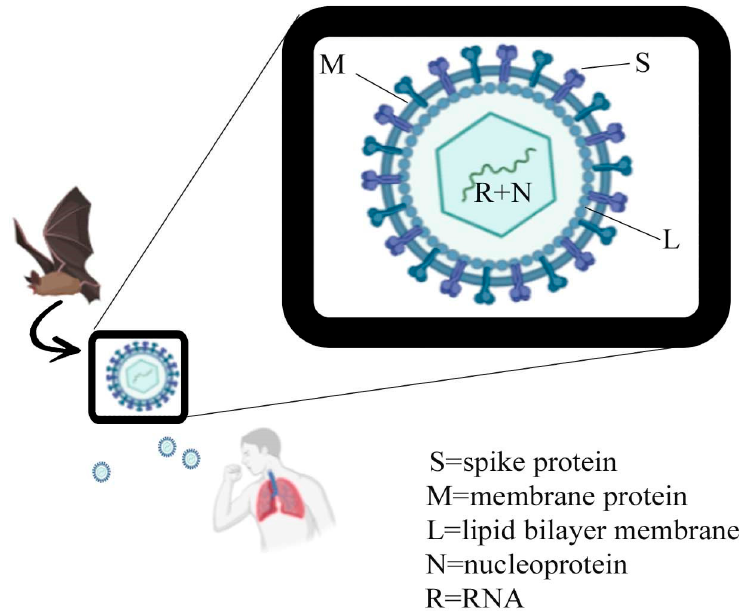
Figure 1. Different proteins and RNA + Nucleoprotein are shown in the structure of the novel SARS- like coronavirus (SARS-CoV-2), originated from the bat and causative agent of